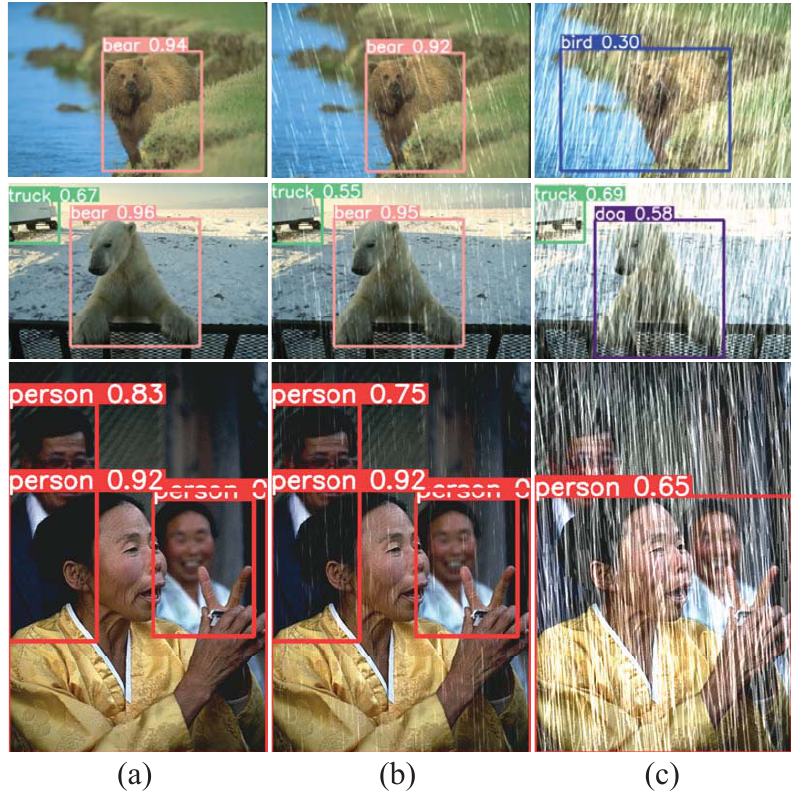
Figure 1. The pre-training model YOLOv5 based on COCO dataset processes the ( a ) clear images and the ( b ) light-rainy images effectively. However, it would lead to missing detection or false detection when the model YOLOv5 processes the ( c ) heavy-rainy